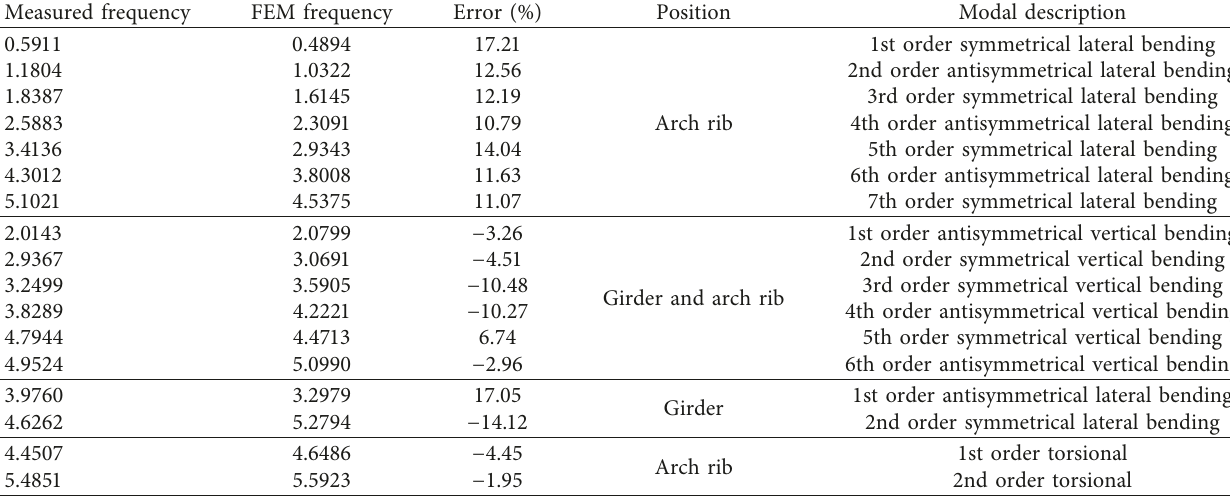
Table 2: Comparison of testing results and FE model results (unit: